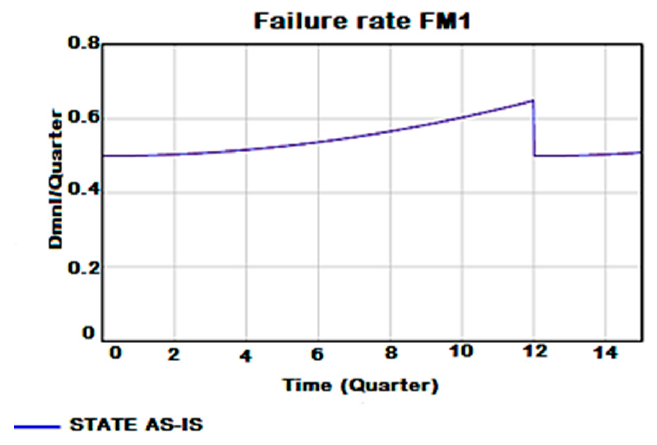
Figure 10. AS-IS FM1 Tunnel chain breakdown. Once the trends of the various failure rates have been identified, all that remains is to identify that of the machine.